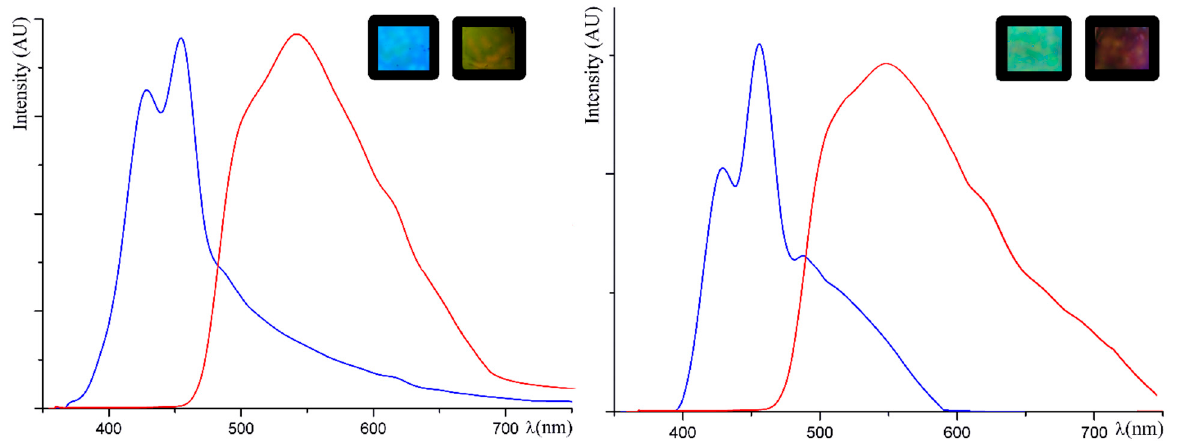
Figure 1. Normalized emission curves were recorded on crystalline thin film samples of Ac1 (blue curve), and Ac2 (red curve) before (on the left ) and after (on the right ) the annealing treatment at 140 °C. In the inset the spin-coated thin films used for recording the emission spectra, were photographed under the UV lamp at 365 nm.